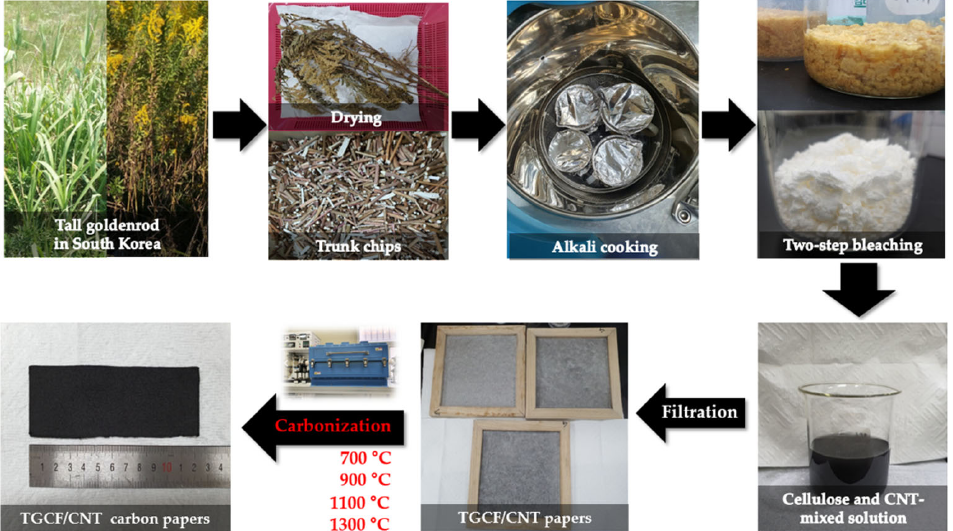
Figure 8. Process for the extraction of cellulose fibers from tall goldenrods and the preparation of TGCF/CNT carbon papers.